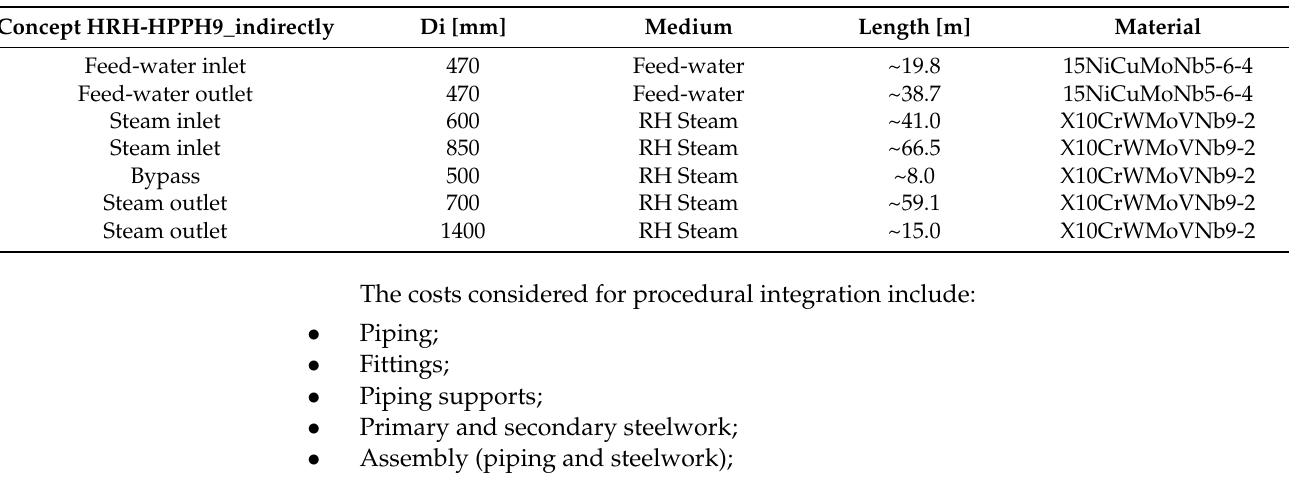
Table 2. Resulting pipeline lengths for concept